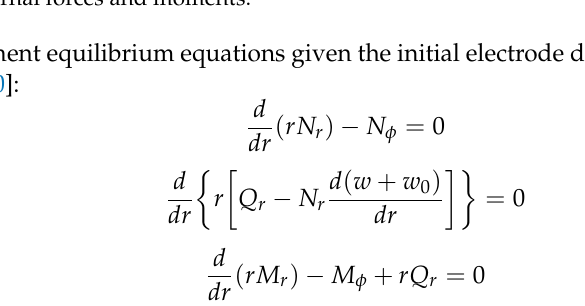
Figure 10. Internal forces and moments.